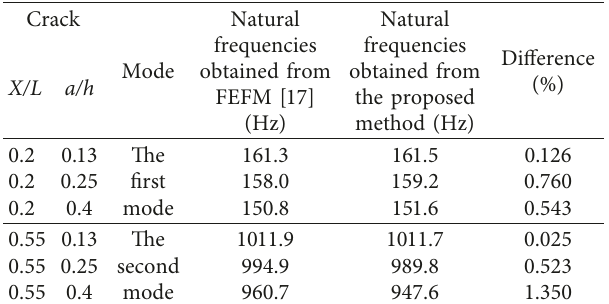
Figure 7: Effects of crack location and crack depth on the first two nondimensional natural frequencies of a cracked cantilever beam with open crack: (a) the first mode; (b) the second Table 2: Comparison of the natural frequencies from the FEFM and proposed method for a cracked cantilever beam.